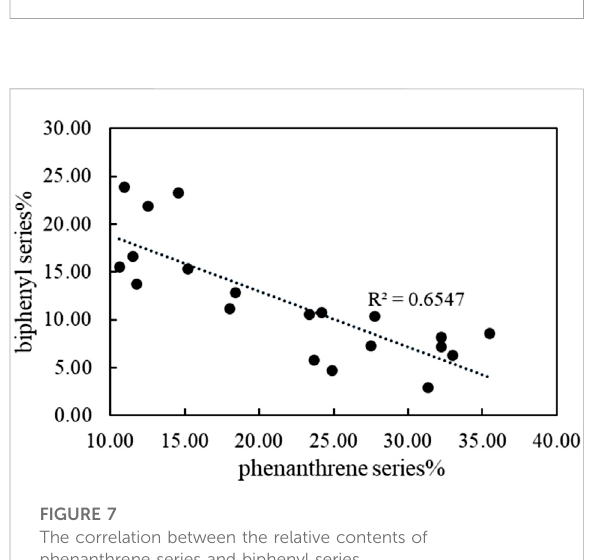
FIGURE 7 The correlation between the relative contents of phenanthrene series and biphenyl series.